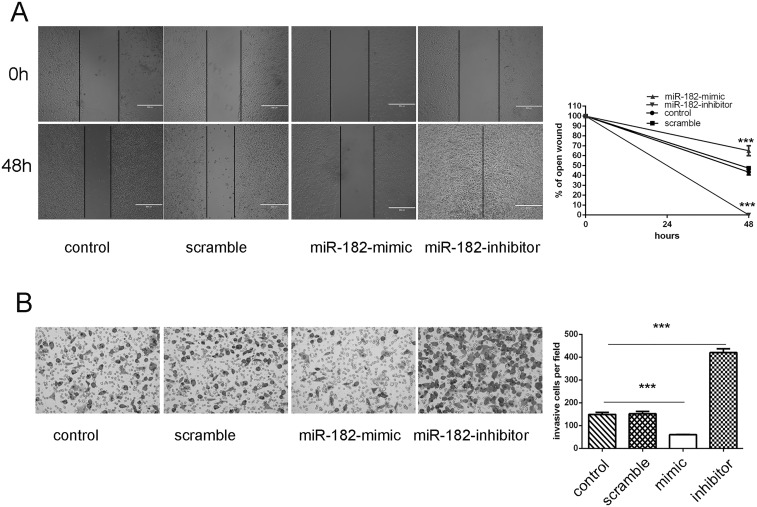
Overexpression of miR-182 inhibited tumor invasion.(A) Wound-healing assay was employed to evaluate the migratory ability of MG-63 cells after treatment with miR-182 mimics, inhibitors or scramble or no transfection. Relative ratio of wound closure is shown on the right. (B) Invasion analysis were employed to evaluate the invasive ability of the MG-63 cells after treatment with miR-182 mimics, inhibitors or scramble or no transfection; the relative ratio of invasive cells per field is shown on the right, *p<0.05, ** p<0.01, and ***p<0.001.